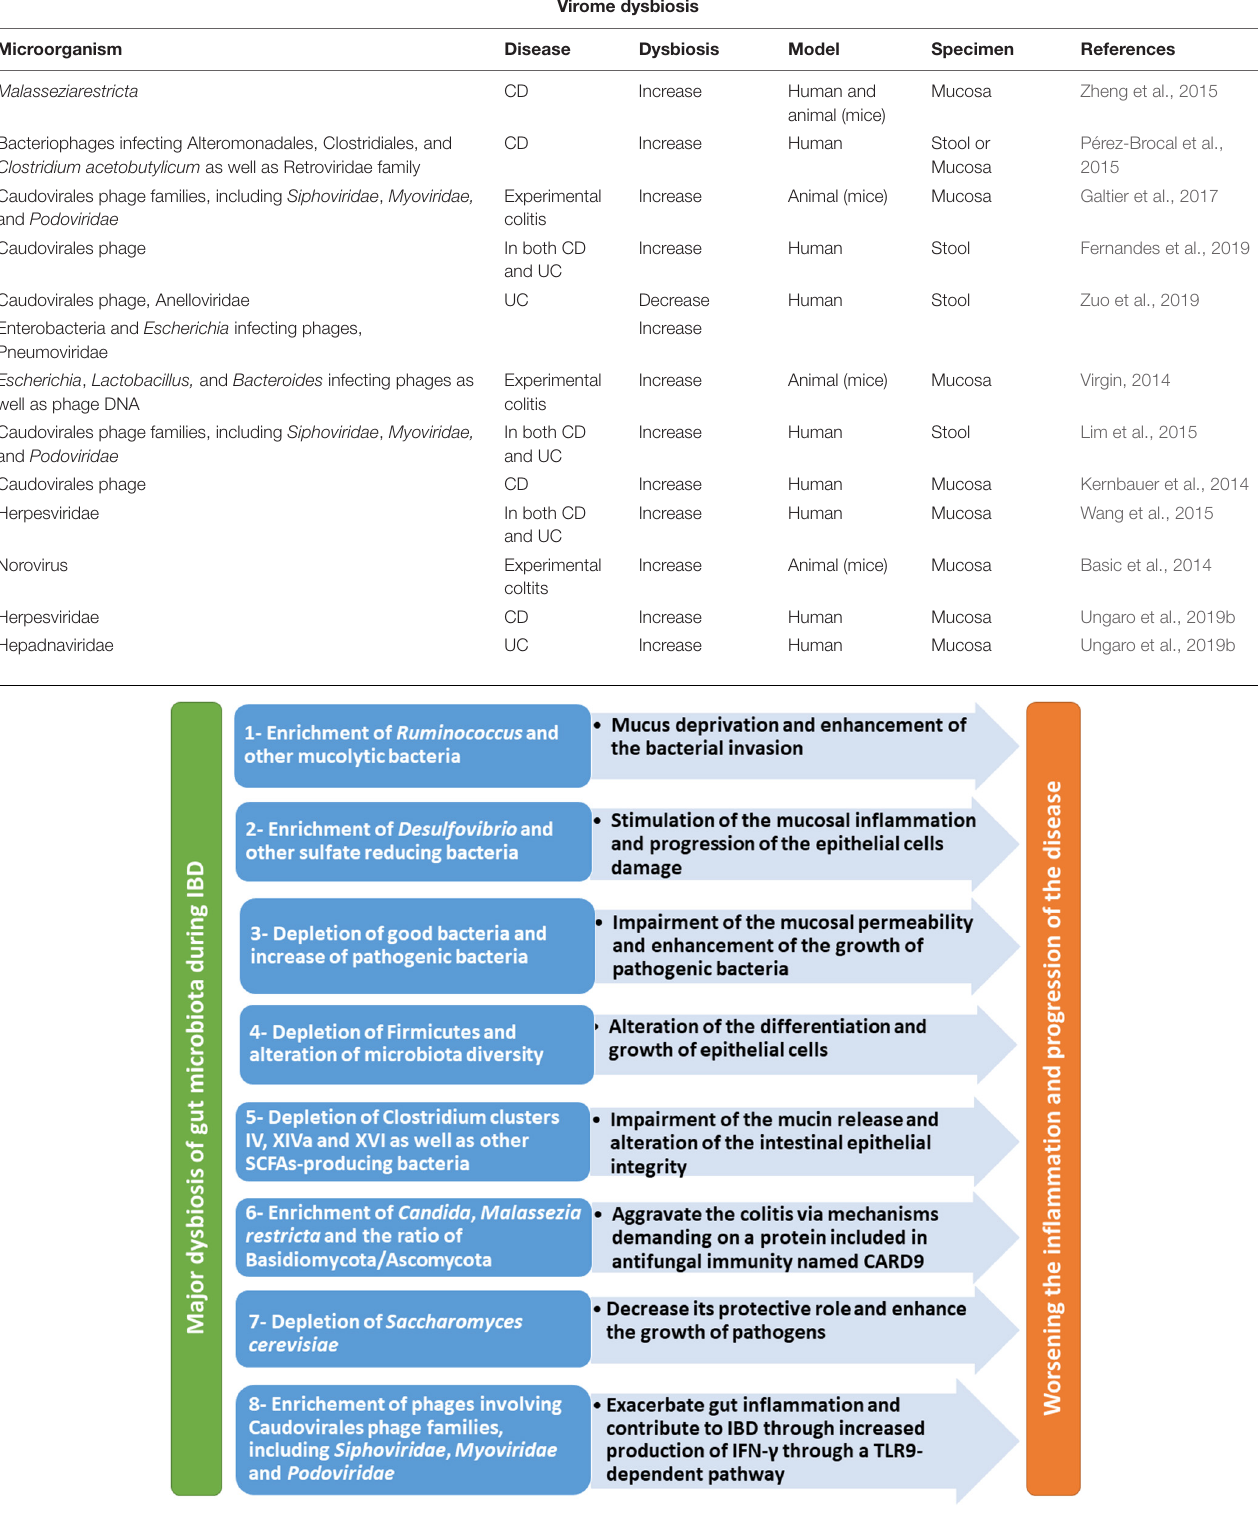
Frontiers in Physiology |